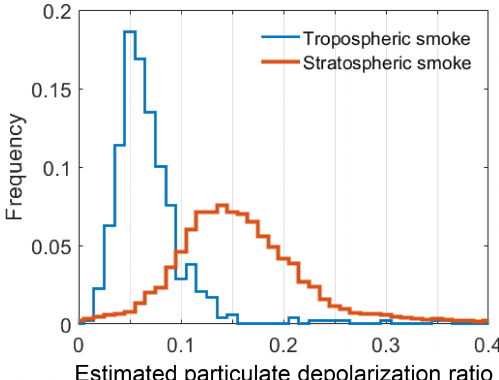
Figure 9. Frequency distributions of estimated particulate depolar- ization ratio ( δ est p ) for stratospheric smoke layers in Table 1 (red) and tropospheric smoke layers contributing to the V4.2 joint dis- tributions (496 layers from the May 2012 Siberian wildfires and 36 layers from July–August 2007 Canadian wildfires). Only layers > 0 . 001sr − 1 with γ (cid:48) 532